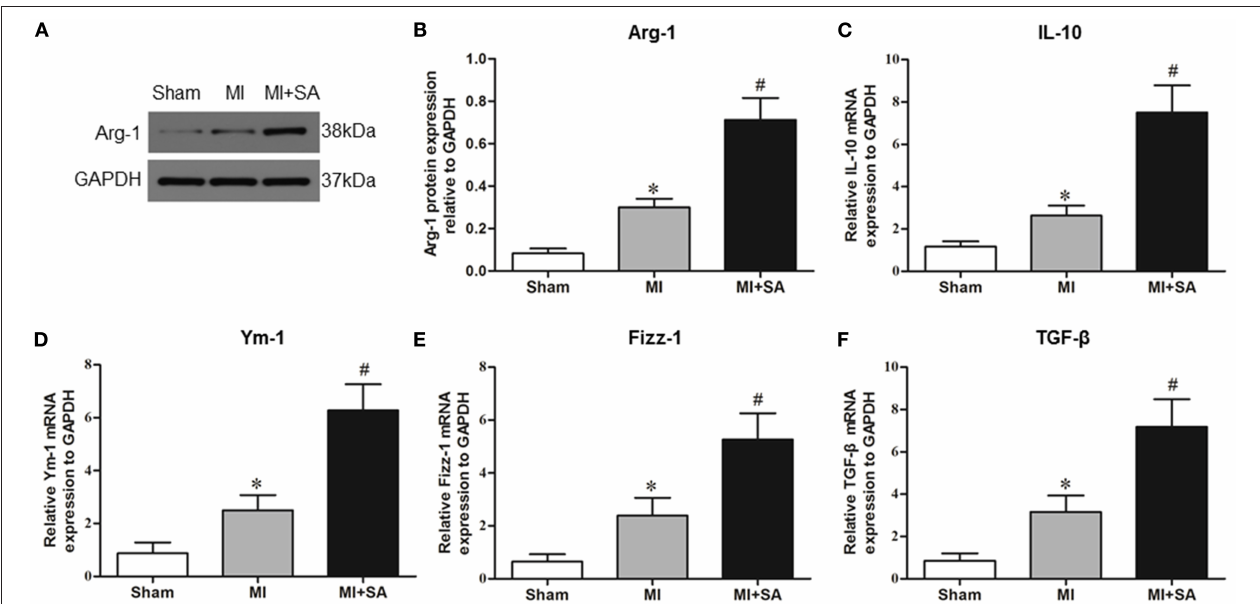
FIGURE 3 | SA promotes M2 macrophage marker expression at 1 week after MI. (A,B) Arg-1 in the three groups was detected by Western blot. (C–F) Levels of the M2 macrophage markers IL-10, Ym-1, Fizz-1, and TNF- β were detected by RT–qPCR. *Compared with the sham group, P < 0.05, # Compared with the MI group, P < 0.05, n = 8 in each group.